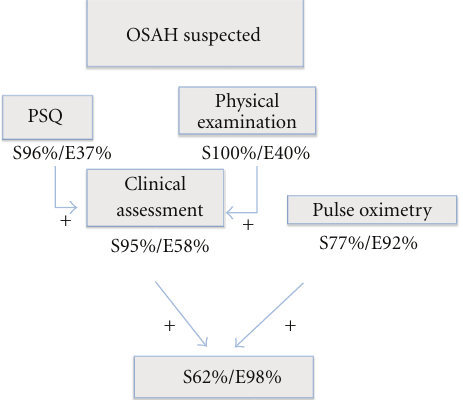
Figure 2: Proposed management algorithm in clinical